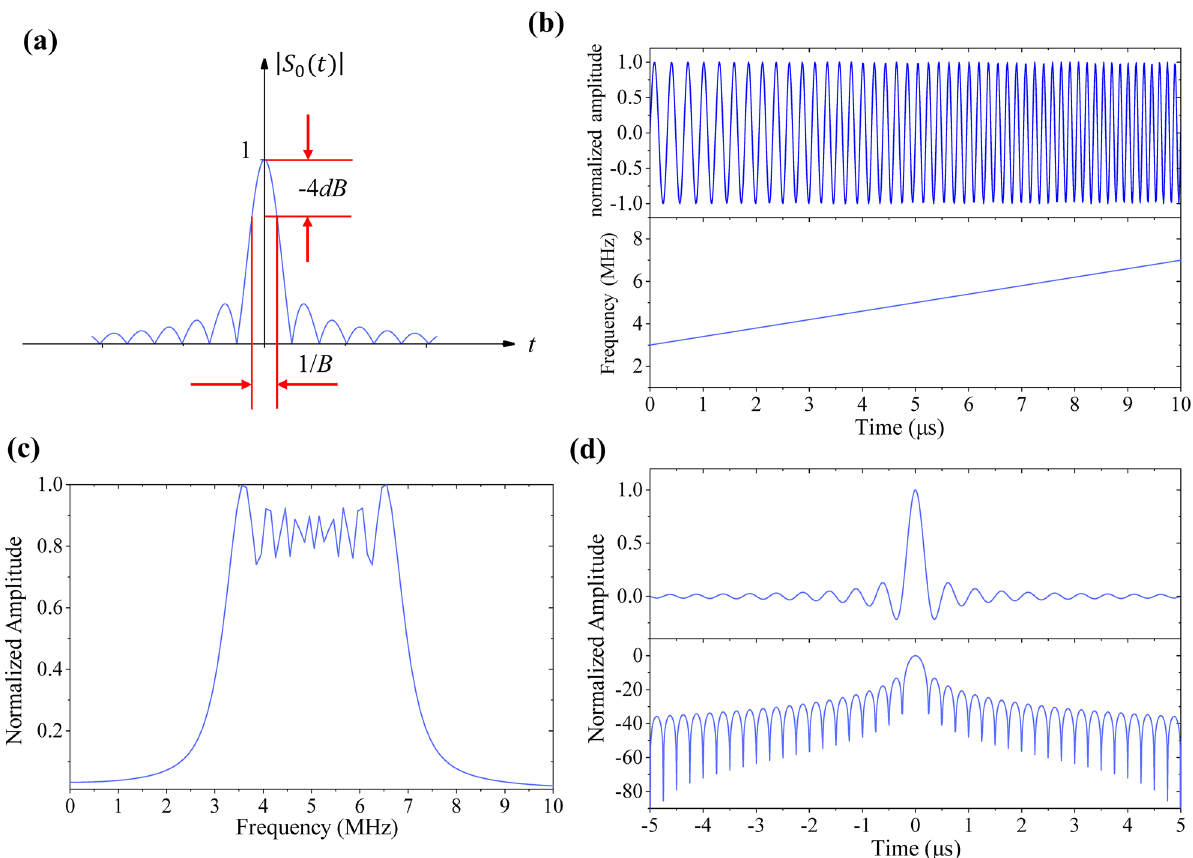
Figure 2. The LFM signal with the time bandwidth of 40. ( a ) The definition of pulse compression signal’s pulse width. ( b ) Time domain waveform and instantaneous frequency of the LFM signal. ( c ) The amplitude- frequency characteristic curve of the LFM signal. ( d ) The time domain waveform of the LFM signal after pulse compression (the top part) and its corresponding signal after logarithm (the bottom